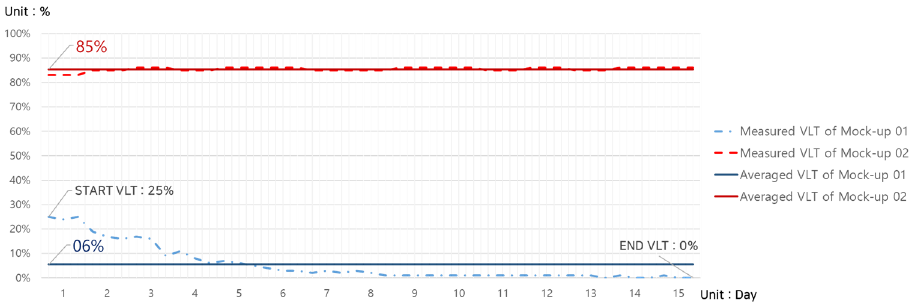
Figure 7. VLT change of mock-up 01 and 02 in summer season.